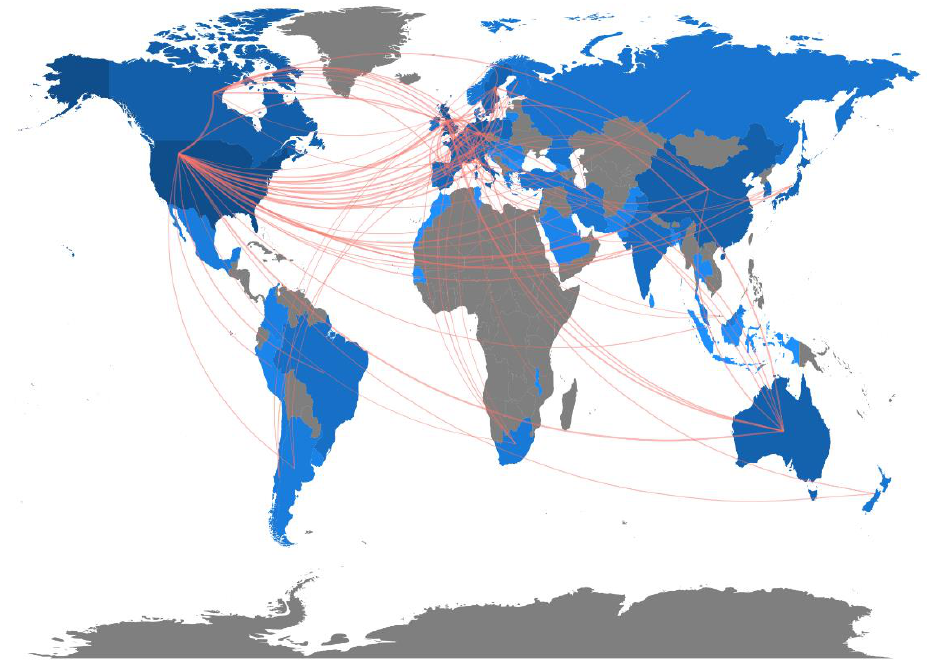
Figure 3. Map of international scientific collaborations for studies investigating eye tracking in different disorders. The color intensity is proportional to the number of international collaborations (gray represents the lack of collaborations retrieved in our search).